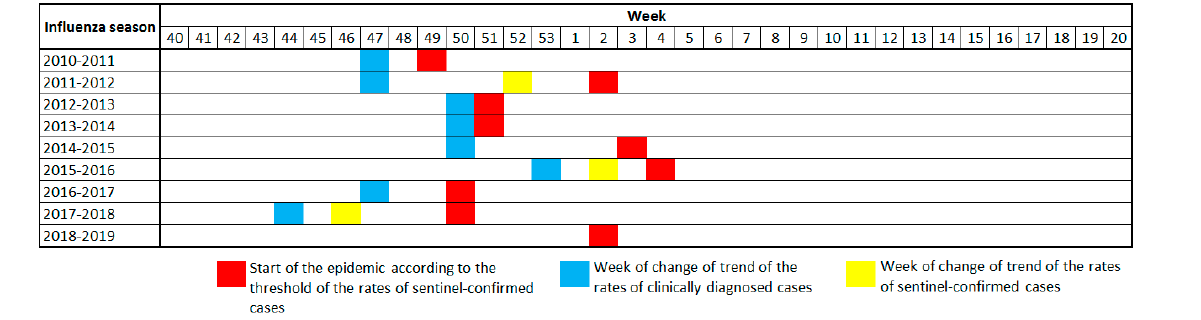
Figure 1. Week of change of trend in pre-epidemic data of clinical diagnoses compared with the beginning of the epidemic, calculated from sentinel-confirmed case rates.